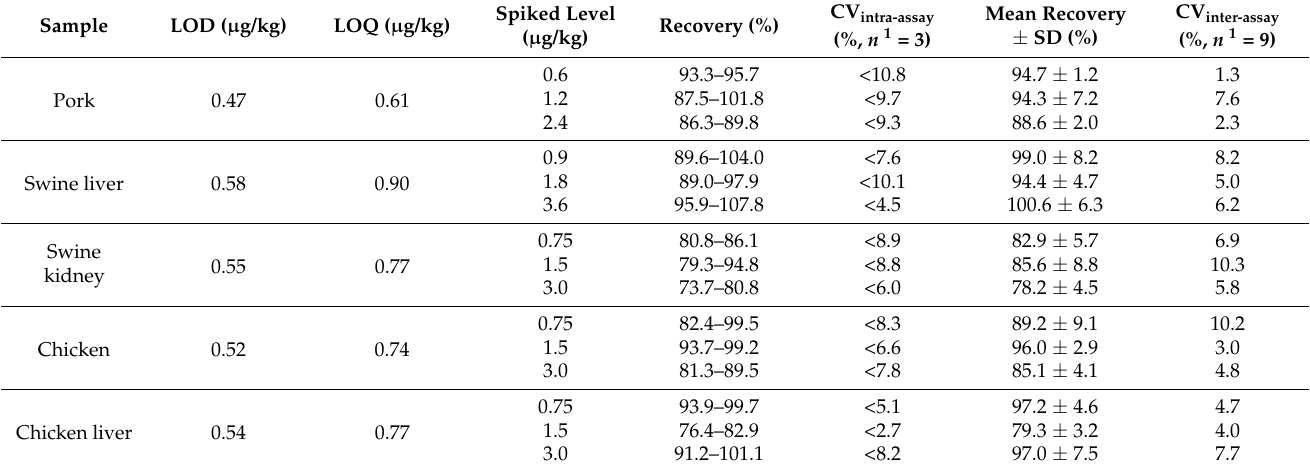
Table 3. LOD, LOQ, and CVs of the samples spiked with